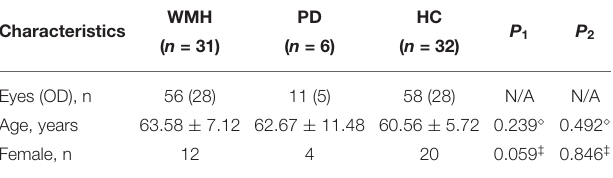
TABLE 1 | Basic characteristics of WMH, PD, and HC